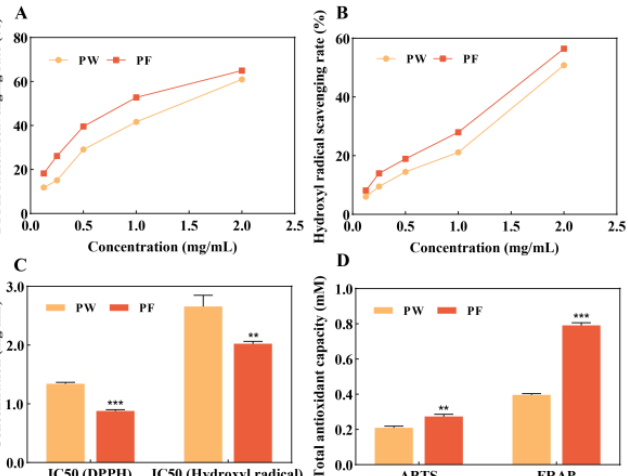
Figure 3. In vitro antioxidant capacity of PW and PF. ( A ): DPPH radical scavenging ability; ( B ) Hydroxyl radical scavenging ability; ( C ): Total antioxidant capacity (ABTS and FRAP methods). ( D ): PW: Passiflora edulis Sims peel water extract. PF: Passiflora edulis Sims peel fermentation broth. Each value is expressed as mean ± SD ( n = 3). (**: p < 0.01, ***: p < 0.001, versus PW